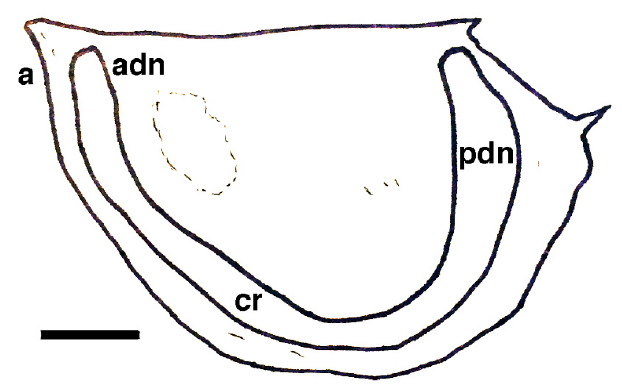
Figure 24. Navarana pearylandica . Anterior to left. Scale bar 100 microns. Abbreviations: adn , anterodorsal node; amr , admarginal rim; pdn , posterodorsal node. Image Credit: Mark McMenamin. Neoduibianella Shu, 1990 [70]; Duibianellidae; Range: Middle Stage 3; with question to early Drumian.